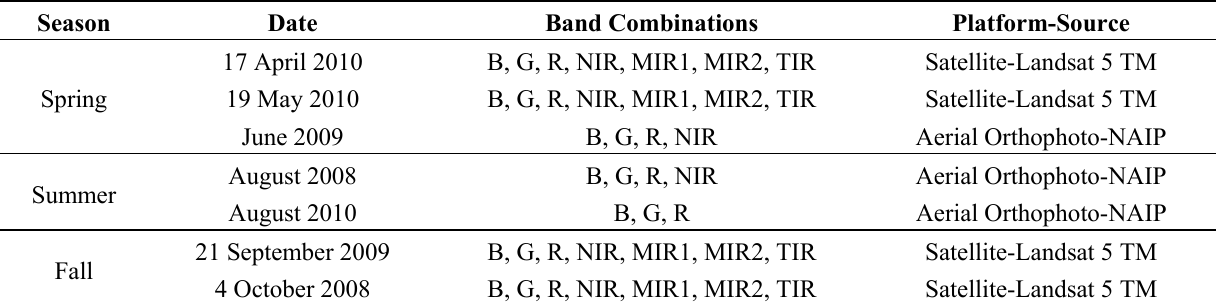
Table 3. Input optical data for decision tree